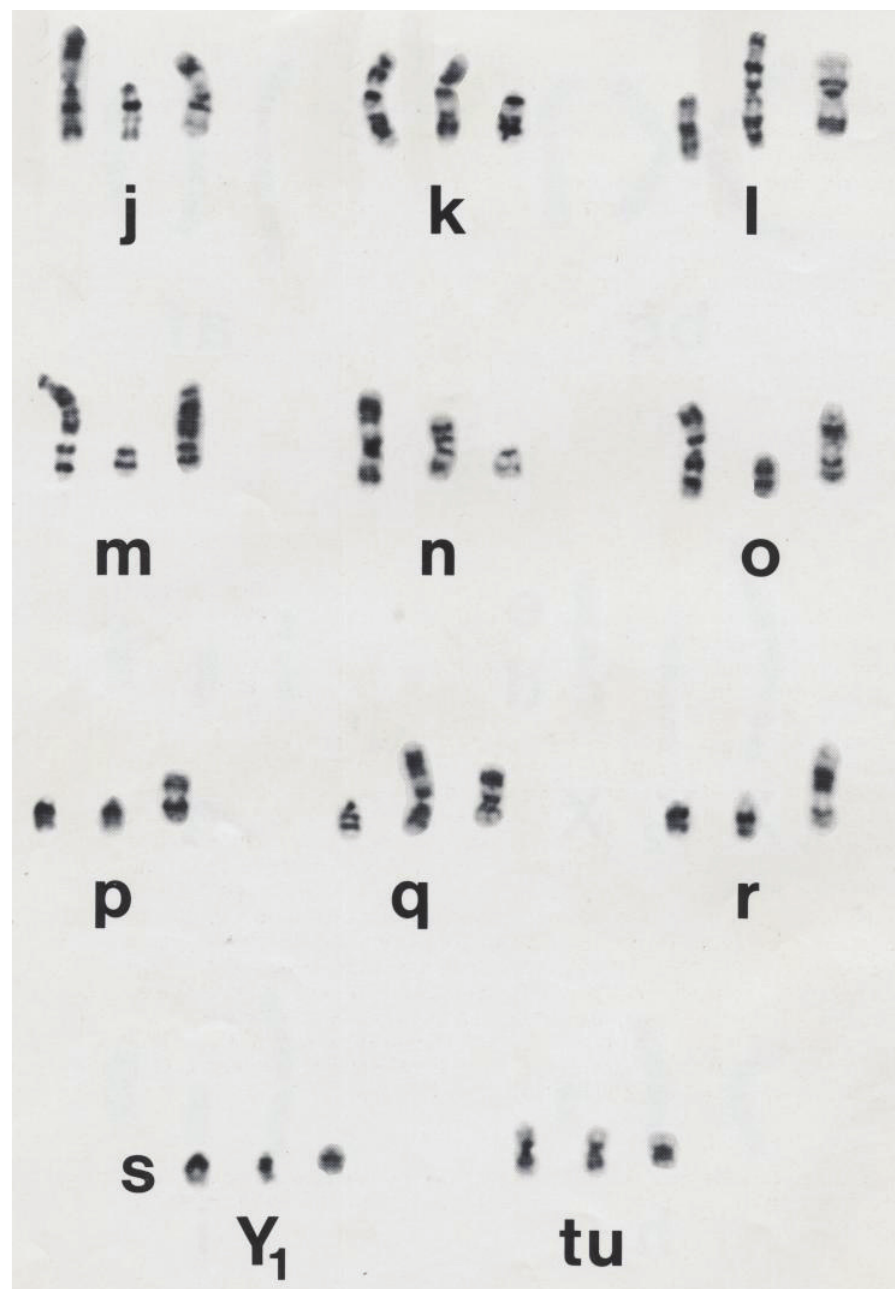
Fig. 2. Chromosome arms j - u. The unlabelled biarmed chromosomes are as follows (given left to right): j: jl, jl; k: kr, kq; l: jl, jl; m: gm, gm; n: kn, mn; o: no, io; p: pr; q: kq, kq; r: